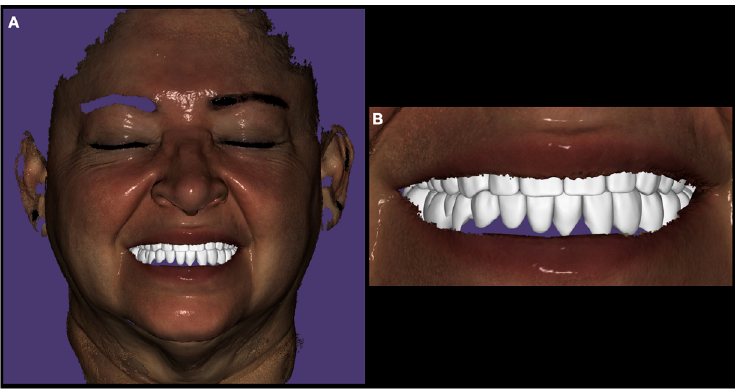
Figure 11. Final extra-oral view. ( A ) Final digital impression. ( B ) Design of final restorations. Final restorations consisted of milled zirconia partial restorations, single crowns (SCs), and fixed dental prostheses (FDPs) (IPS e.max ZirCAD, Ivoclar Vivadent, Schaan, Liechtenstein) cemented with resin cement (Multilink Automix, Ivoclar Vivadent) (Figure 12). A full mouth radiograph series is shown in Figure 13.